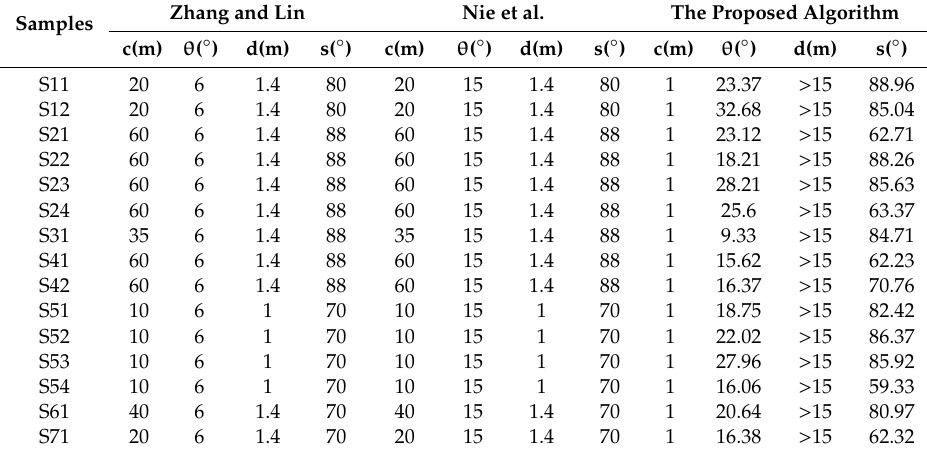
Table 2. The values of parameters in all filters for each sample. Note that “c”, ” θ ”, “d” and “s” represent “grid cell size”, “maximum angle”, “maximum distance” and “maximal terrain slope”, respectively. Zhang and Lin Nie et al. Samples